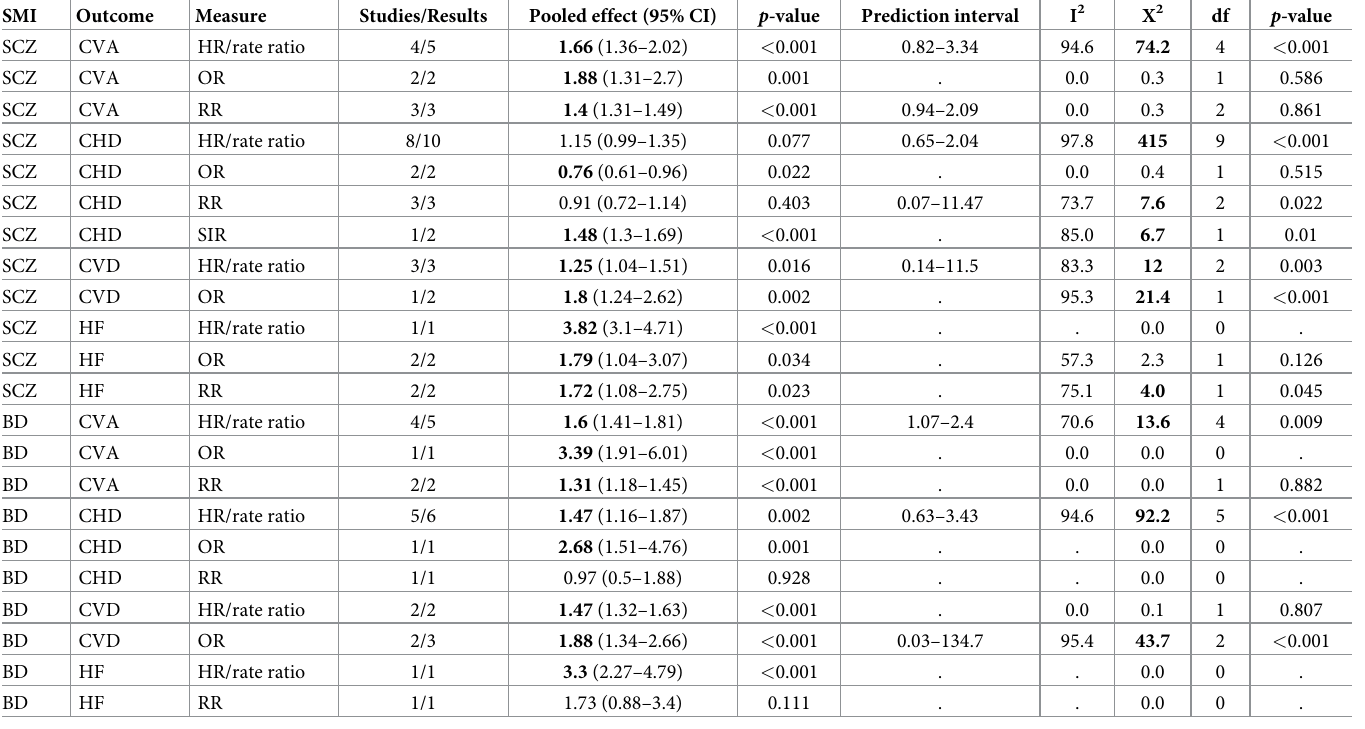
Table 2. Pooled relative risks of cardiovascular incidence by SMI and cardiovascular